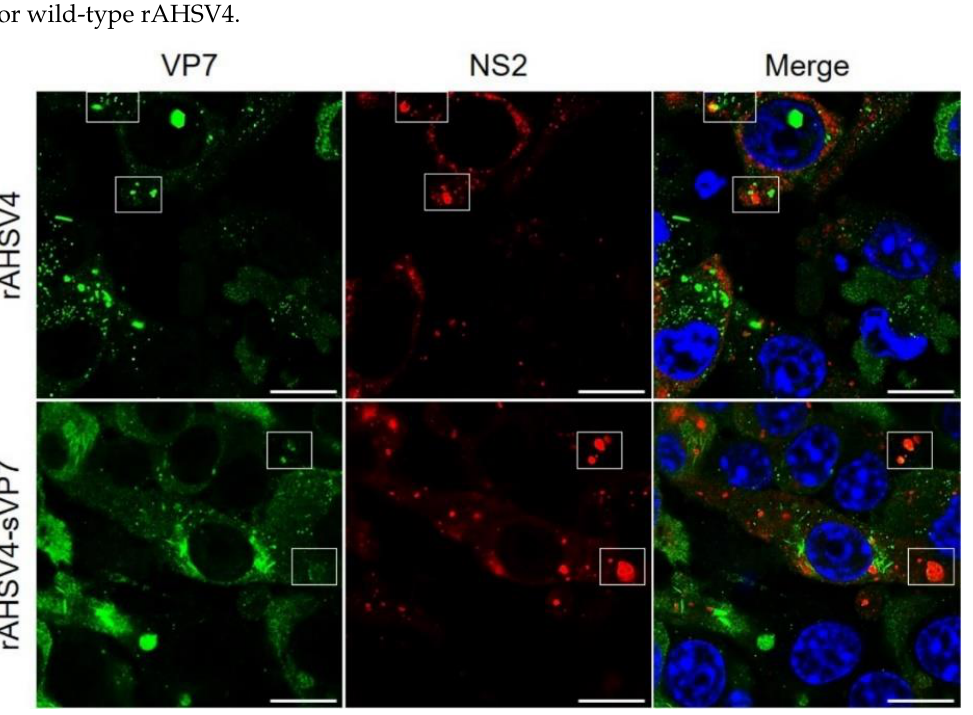
Figure 3. Intracellular distribution of AHSV VP7 with viral inclusion body mediator protein NS2 in wild-type rAHSV4 (top panel) and mutant rAHSV4-sVP7 (bottom panel). Boxes indicate VP7 foci association alongside VIBs. BSR cell monolayers, seeded on coverslips, were infected at a MOI of 0.1 of each virus, incubated for 48 h, fixed and labelled as described in Section 2.5. VP7 was labelled with anti-VP7 guinea pig primary antibody and detected using Alexa Fluor 488 anti-guinea pig secondary antibody (green). NS2 was labelled with anti-NS2 rabbit primary antibody and detected using Alexa Fluor 647 anti-rabbit secondary antibody (red). Nuclei were stained with DAPI (blue). Images are split into separate channels (green and red) with channels merged on the right. Areas of colocalisation are indicated by yellow in merged images. Scale bars represent 10 µm.